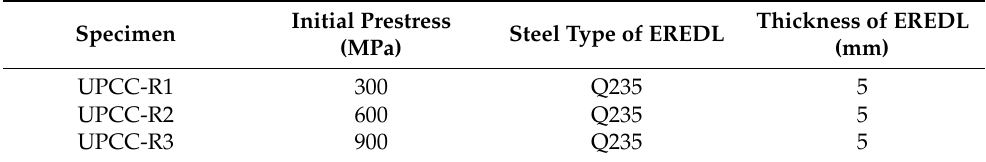
Table 7. Bridge pier working conditions under different initial